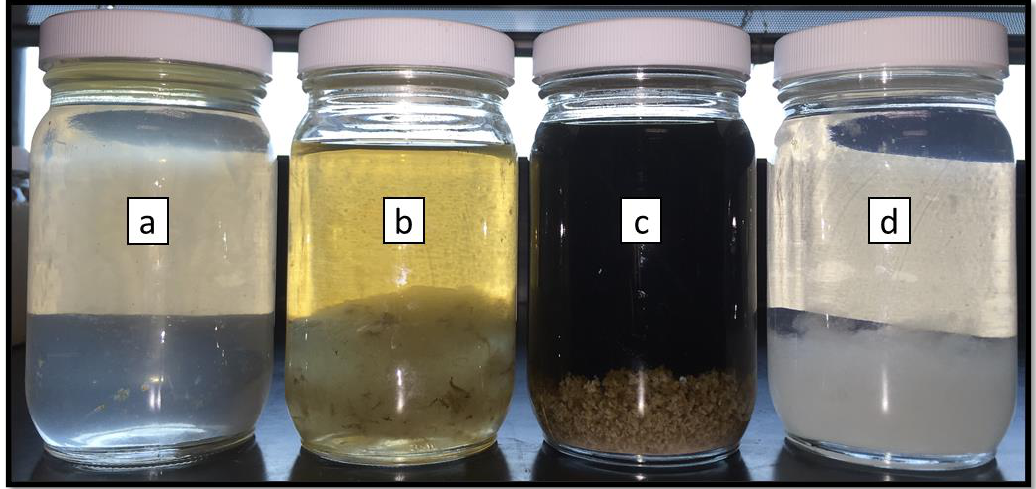
Figure 6. Residual polymer in the broken crosslinked fracturing fluid samples after exposure to different gel breakers (( a ): enzyme—5 gpt, ( b ): acid—2 gpt, ( c ): bromate–8 ppt, ( d ): persulfate—8 ppt) after 24 h at 200–300 °F.